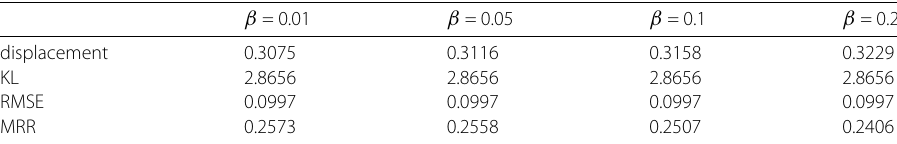
Table 3 The effects of applying different damping factors β β = 0.01 β = 0.05 β = 0.1 β = 0.2 displacement